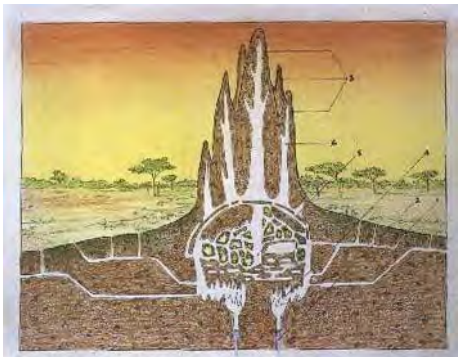
Figure 8. To show a termite colony and the ventilation idea from inside to outside and discarding refuses underneath